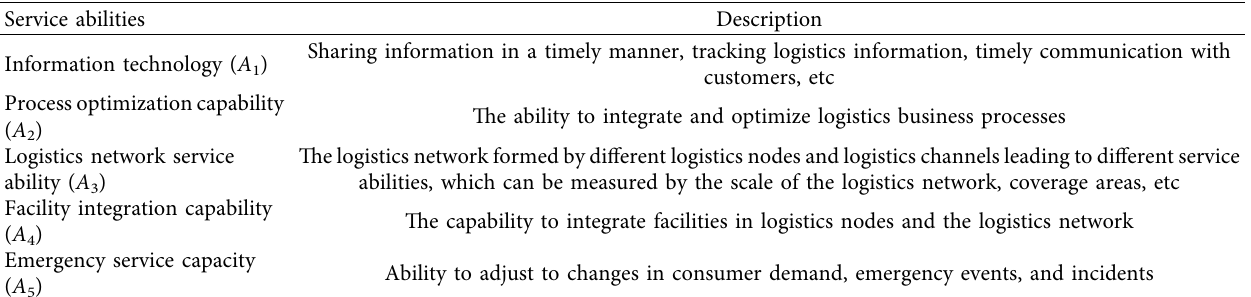
Table 3: MC logistics service abilities: HOWs.